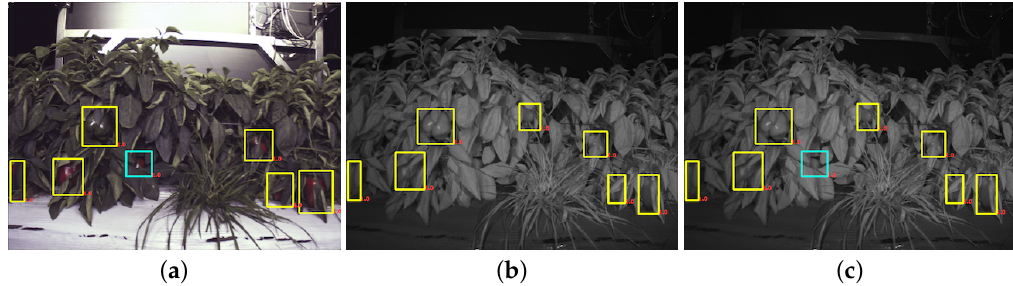
Figure 7. ( a , b ) The hand-labelled ground truth using an RGB image and an NIR image respectively; ( c ) A merged ground truth bounding box. The cyan box displays a bounding box that is correctly annotated using the RGB image, but missed in the NIR image, due to the poor visibility of a fruit.